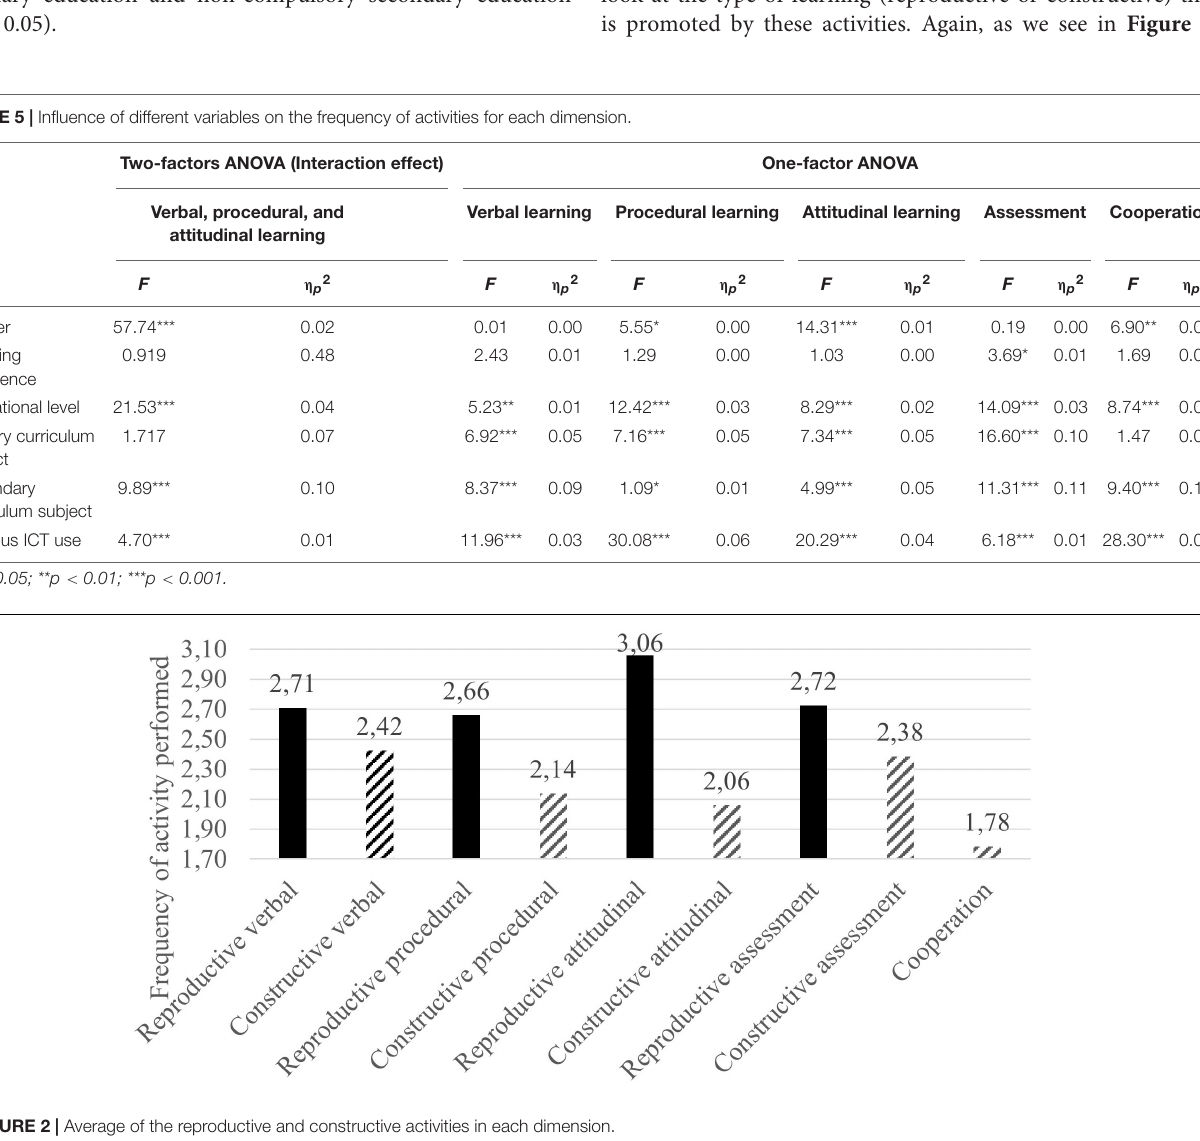
FIGURE 2 | Average of the reproductive and constructive activities in each